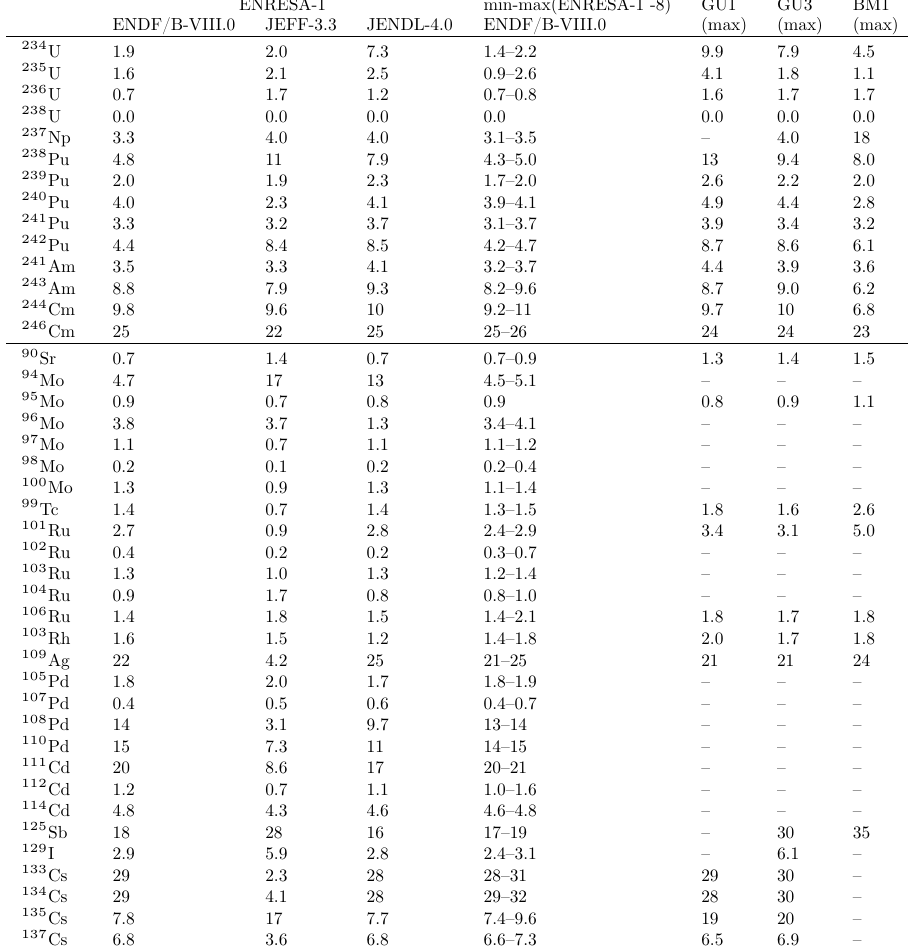
Table A.1. Uncertainties ∆ C from nuclear data libraries for the ENRESA samples for the isotopic concentrations (CASMO5-1 calculations). All values are in %. The last three columns present the maximum uncertainties (due to nuclear data) for the PWR samples GU1, GU3 and BM1 (BM1 being a MOX